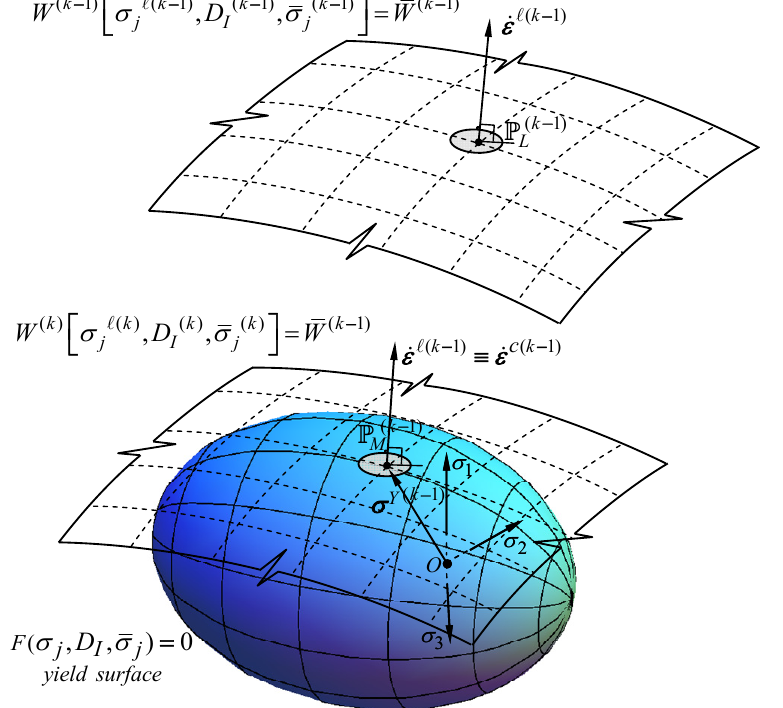
Figure 1: Geometrical sketch, in the principal stress space, of the matching procedure, from iteration ( k -1) to ( k ) at the current GP within the current